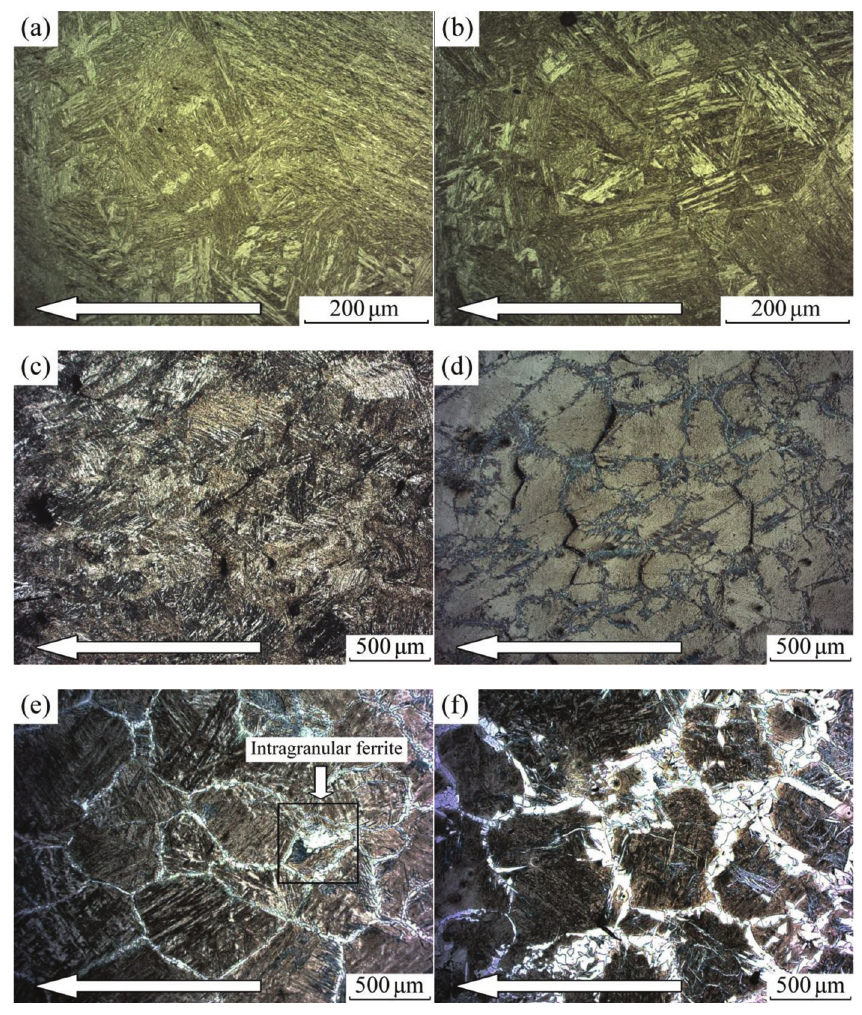
Figure 4: Longitudinal sectional micrographs of steel sample A and steel B: (a) steel A, 900°C; (b) steel B, 900°C; (c) steel A, 850°C; (d) steel B, 850°C; (e) steel A, 800°C; (f) steel B, 800°C. Note: The arrows indicate the tensile